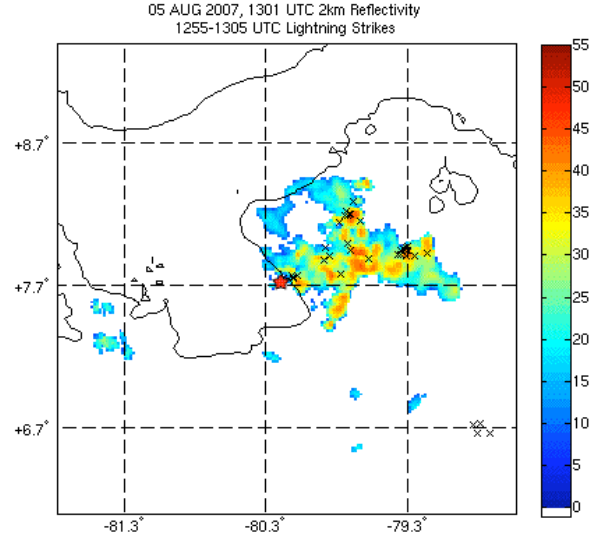
Fig. 2. Low-level (0.7 elevation) PPI images of convection observed Figure 2. Low-level (0.7 elevation) PPI images of convection observed east of NPOL at 1311 3 east of NPOL at 13:11UTC 5 August 2007. The color scale has UTC 05 Aug 2007. The color scale has units of radar reflectivity (dBZ). Each “X” marks the 4 units of radar reflectivity (dBZ). Each “X” marks the location of a location of a detected WWLLN lightning strike. The red star marks the location of Las Tab-5 detected WWLLN lightning strike. The red star marks the location las. 6 of Las 7